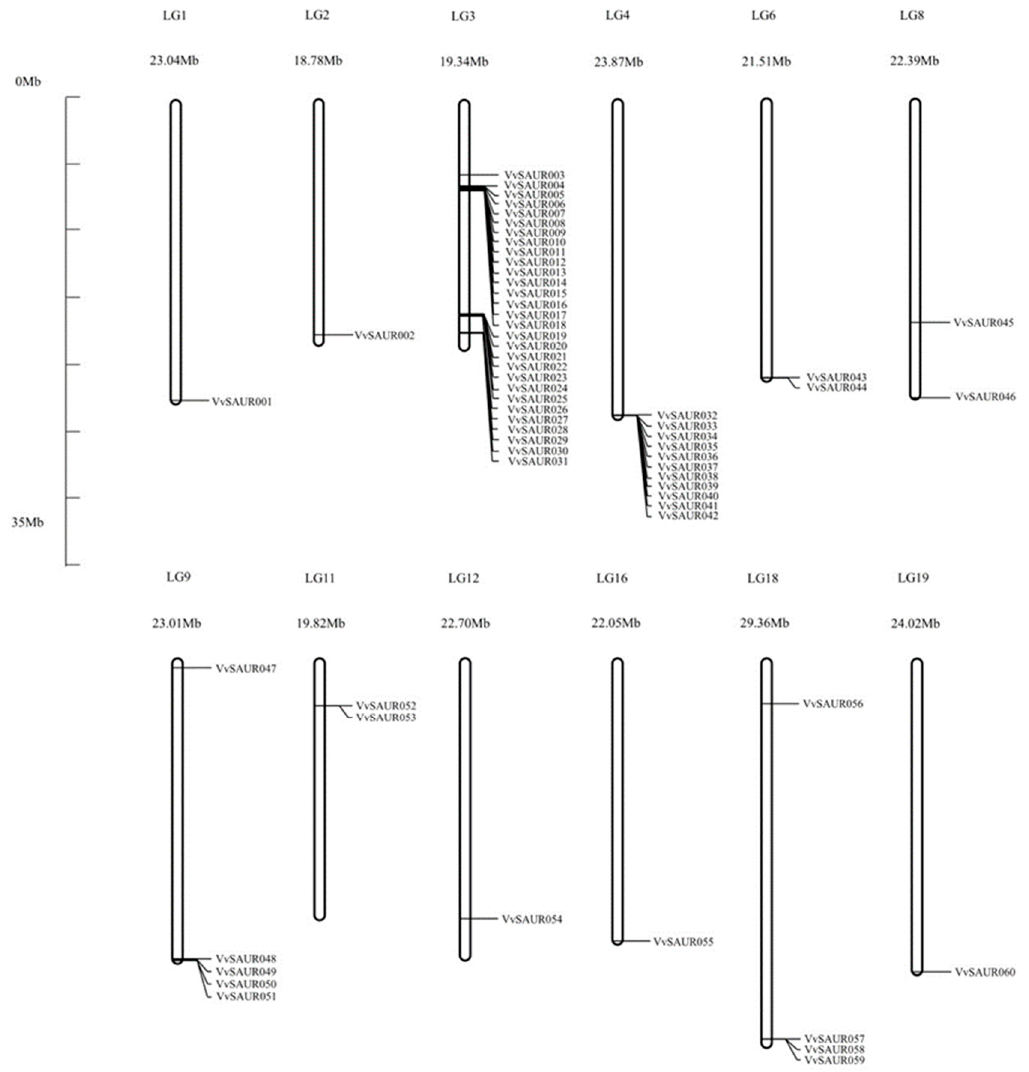
Figure 1. Distribution of 60 VvSAUR genes on grape chromosomes. Centromeric positions are shown according to location of each VvSAUR gene.